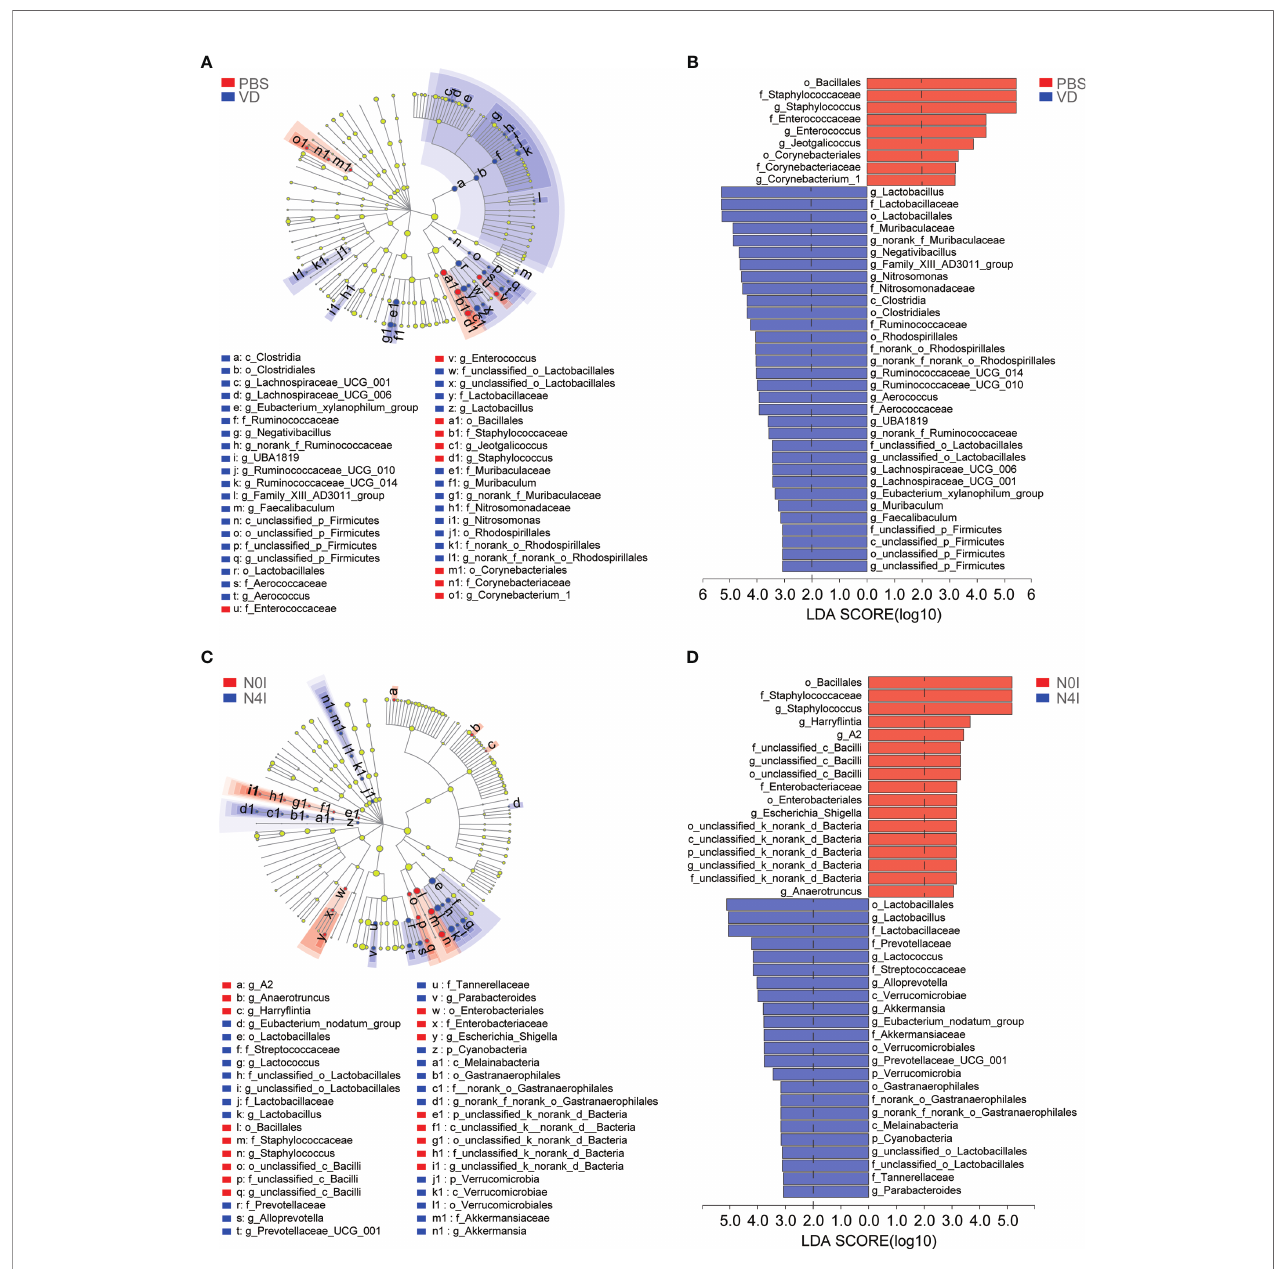
FIGURE 4 | LEfSe analysis of gut microbiota taxa in control, VD, and mCRAMP-encoding L. lactis – treated mice. (A, C) LEfSe cladograms were built to show the differently abundant bacteria in each group. Red nodes represent the bacterial biomarkers with highest abundance in PBS (A) or N0I (C) groups, while blue nodes indicate the predominant bacterial biomarkers in VD (A) or N4I (C) groups. “ p ” referred to phylum, “ c ” referred to class, “ o ” referred to order, “ f ” referred to family, “ g ” referred to genus. (B, D) Bar plots show linear discriminant analysis (LDA) scores, which are interpreted as the degree of consistent difference in relative abundance of fecal bacterial communities across each group. Red bars represent the bacterial biomarkers with highest abundance in PBS (B) or N0I (D) groups, while blue bars indicate the predominant bacterial biomarkers in VD (B) or N4I (D) groups. LDA score greater than 2 was considered a difference in bacterial abundance among each group. The LEfSe analysis was analyzed by LEfSe software